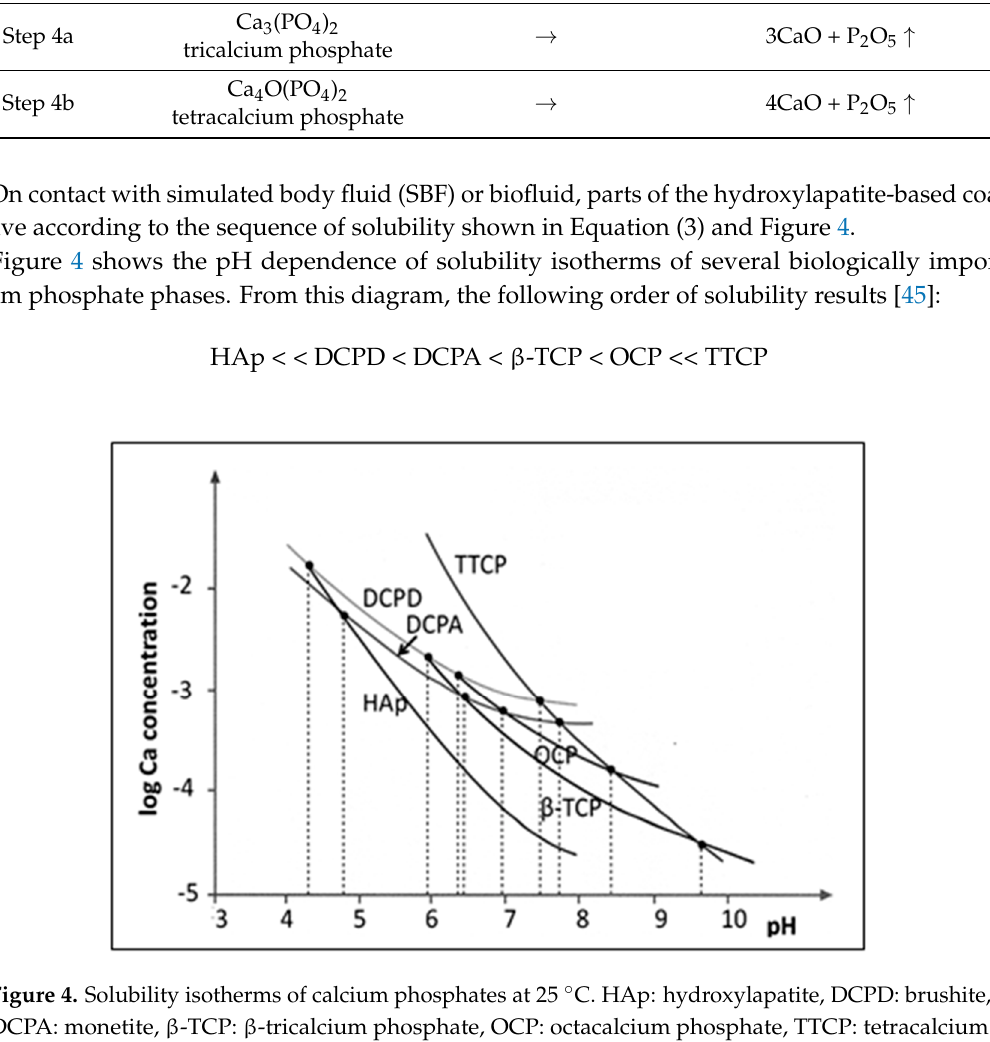
Figure 4. Solubility isotherms of calcium phosphates at 25 °C. HAp: hydroxylapatite, DCPD: brushite, DCPA: monetite, β -TCP: β -tricalcium phosphate, OCP: octacalcium phosphate, TTCP: tetracalcium phosphate [1]. © With permission by Wiley-VCH.